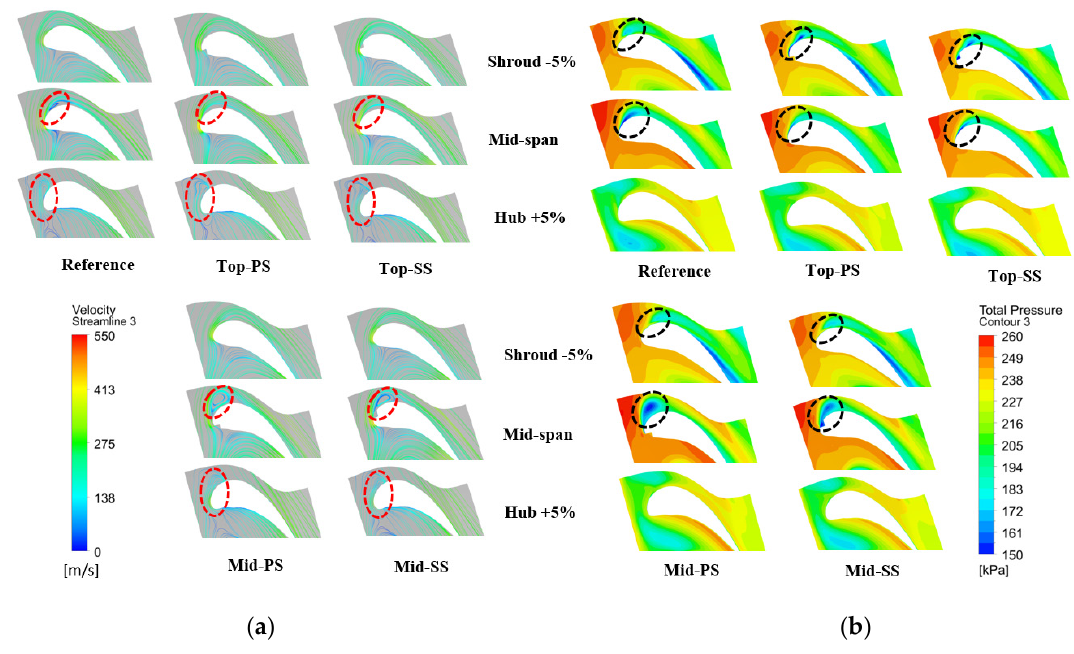
Figure 5. ( a ) Velocity streamlines; ( b ) total pressure contours at different span-wise locations of the R 1 blade.